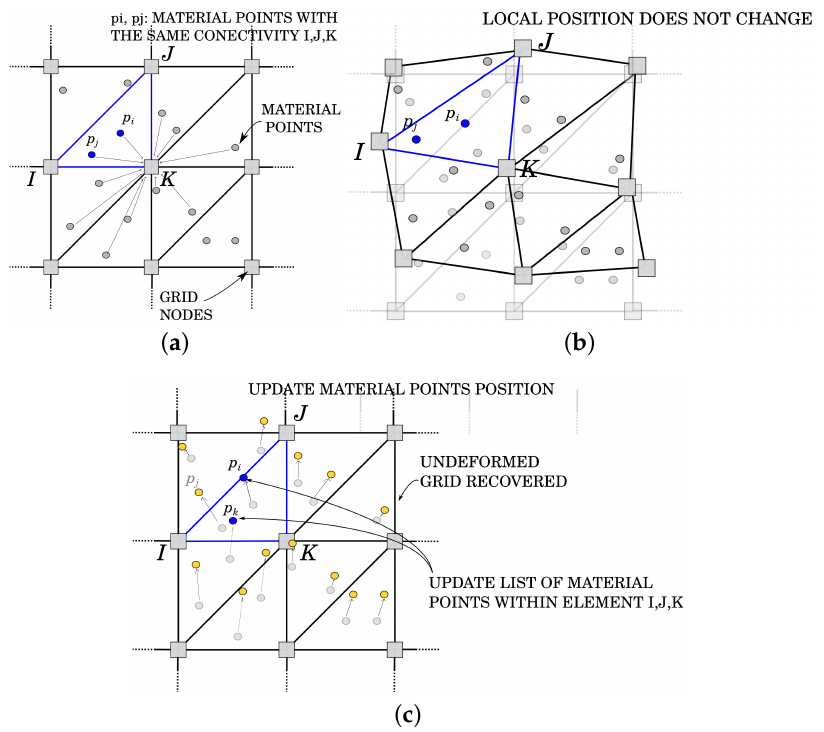
Figure 2. MPM phases. ( a ) Initialization phase; ( b ) Updated Lagrangian FEM phase; ( c ) Convective